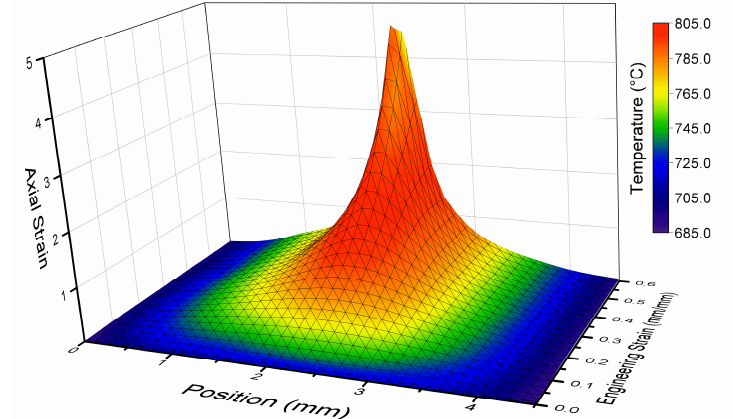
Fig 4. Surface plot of local axial strain as a function or position along the gauge length and global engineering strain of a specimen under tension at a strain rate of approximately1600 s -1 and an initial temperature of 700 °C. The plot is colour coded so that it possible to visualize the local surface temperature of the specimen in the same representation as the local axial